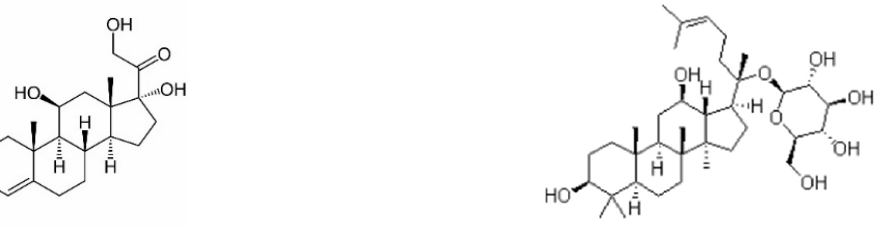
Figure 2. Chemical structure of the stress hormone cortisol and the Compound K [118], the primary active metabolite of ginsenosides.